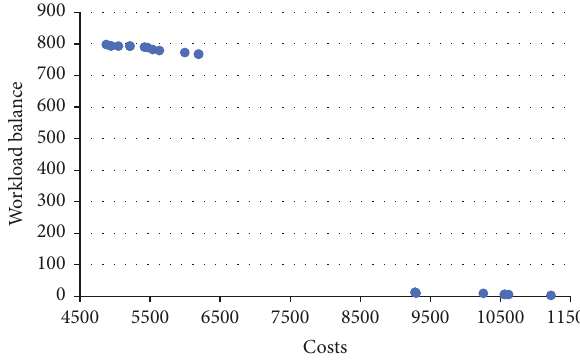
Figure 8: Approximation of the Pareto front of Instance 7.